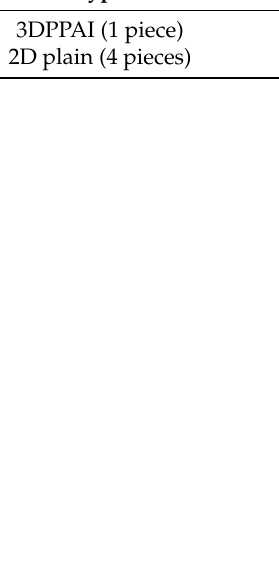
Figure 12. Comparison of bending properties of 3DPPAI and 2D plain weave